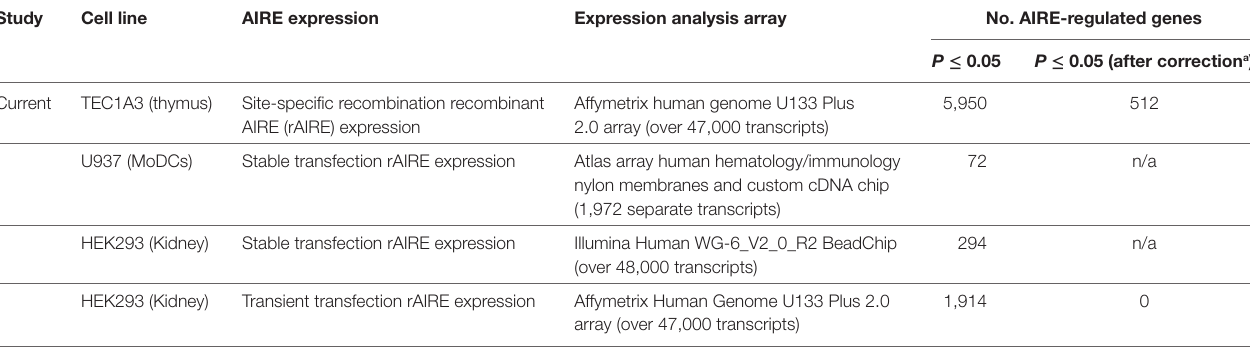
TaBle 1 | Comparison of different human cell line models of autoimmune regulator (AIRE)/AIRE-regulated gene expression.